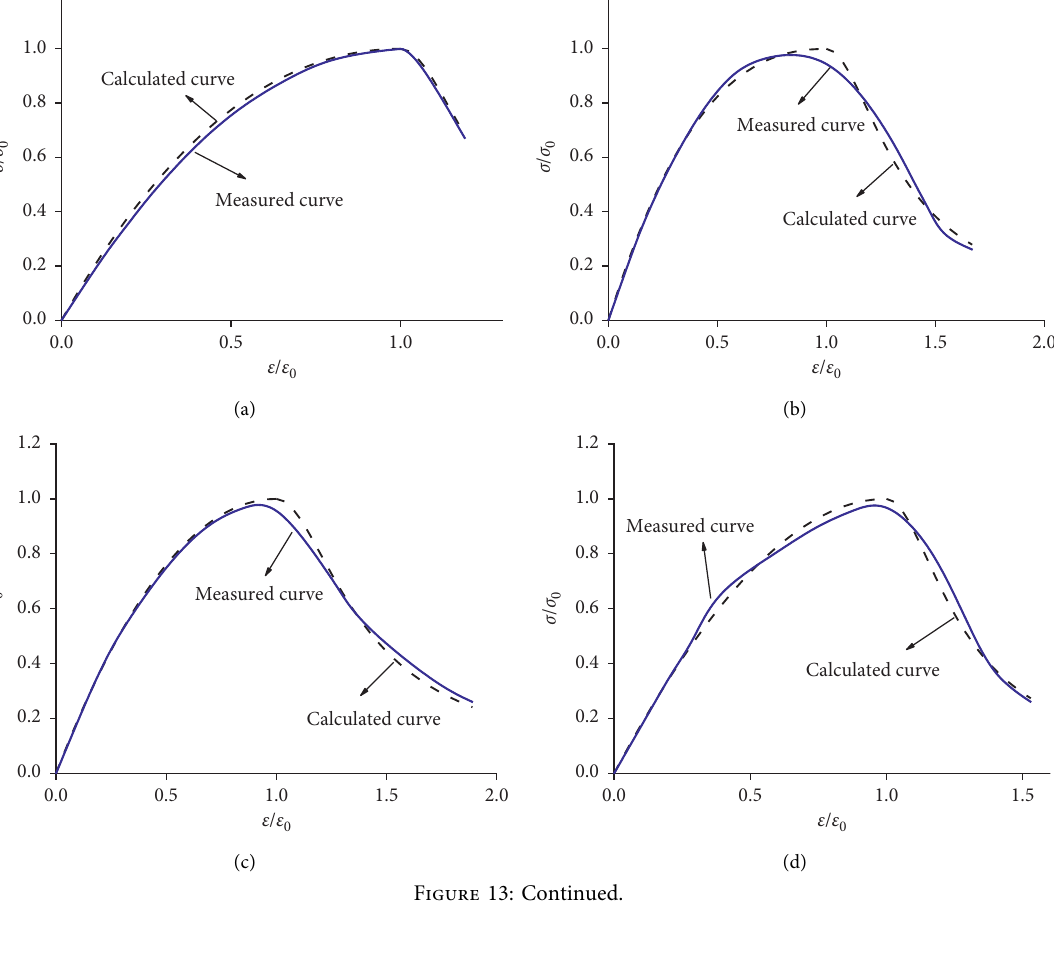
Figure 12: The relation curve of α